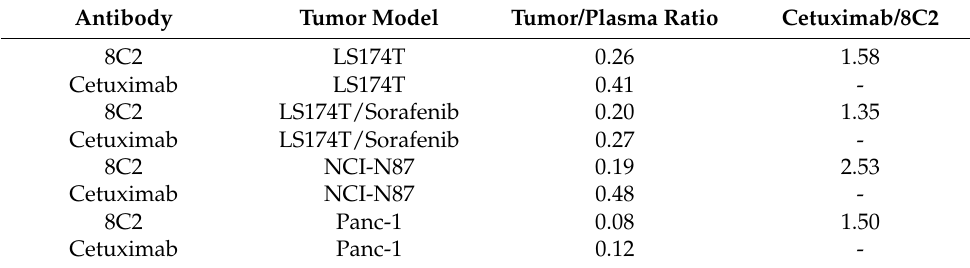
Table 1. Antibody Tumor-to-Plasma Ratio by Tumor